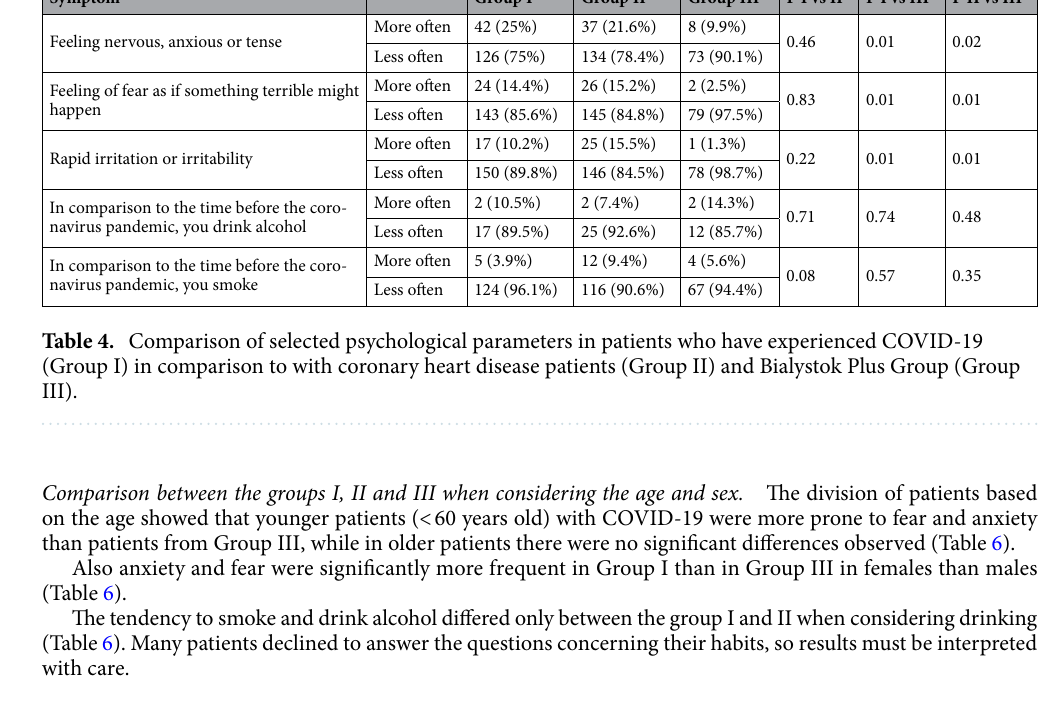
(Table 6). Many patients declined to answer the questions concerning their habits, so results must be interpreted with care.